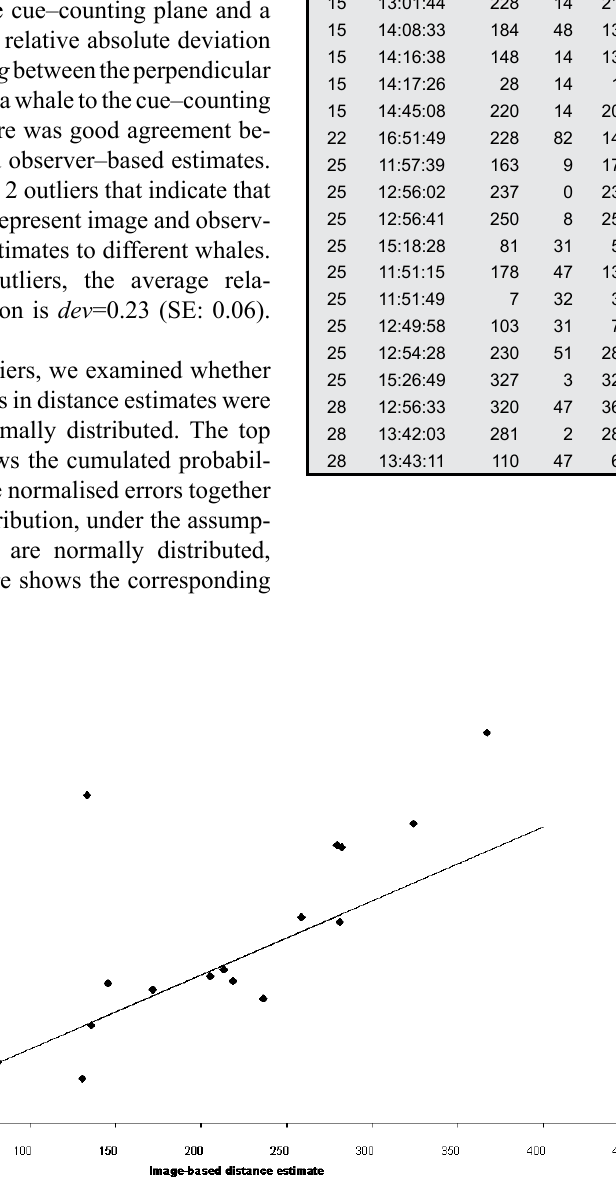
Fig. 3. The observer based estimates of the perpendicular distance given as a function of the image based estimates. The solid line represents the case where the 2 distances are